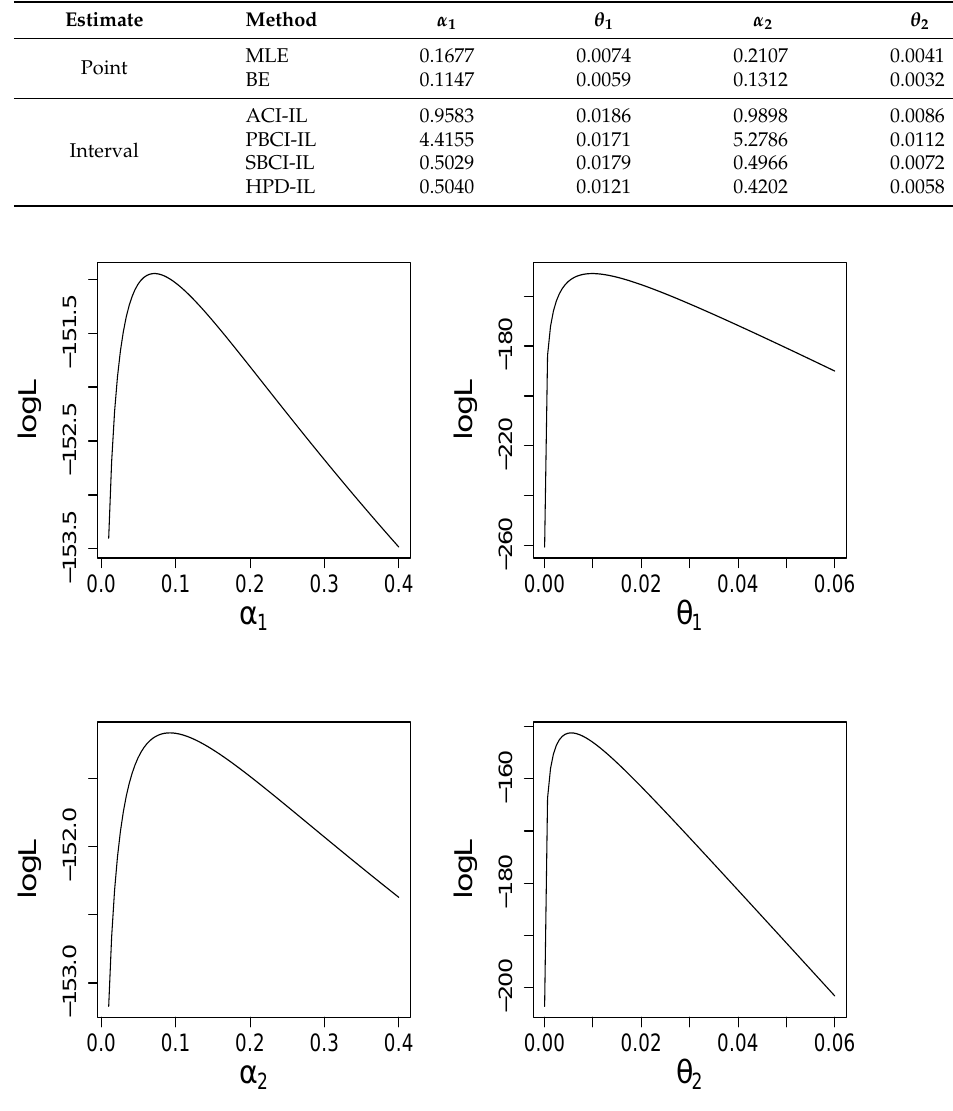
Figure 6. The log-likelihood functions of ( α 1 , θ 1 , α 2 , θ 2 ) for the real